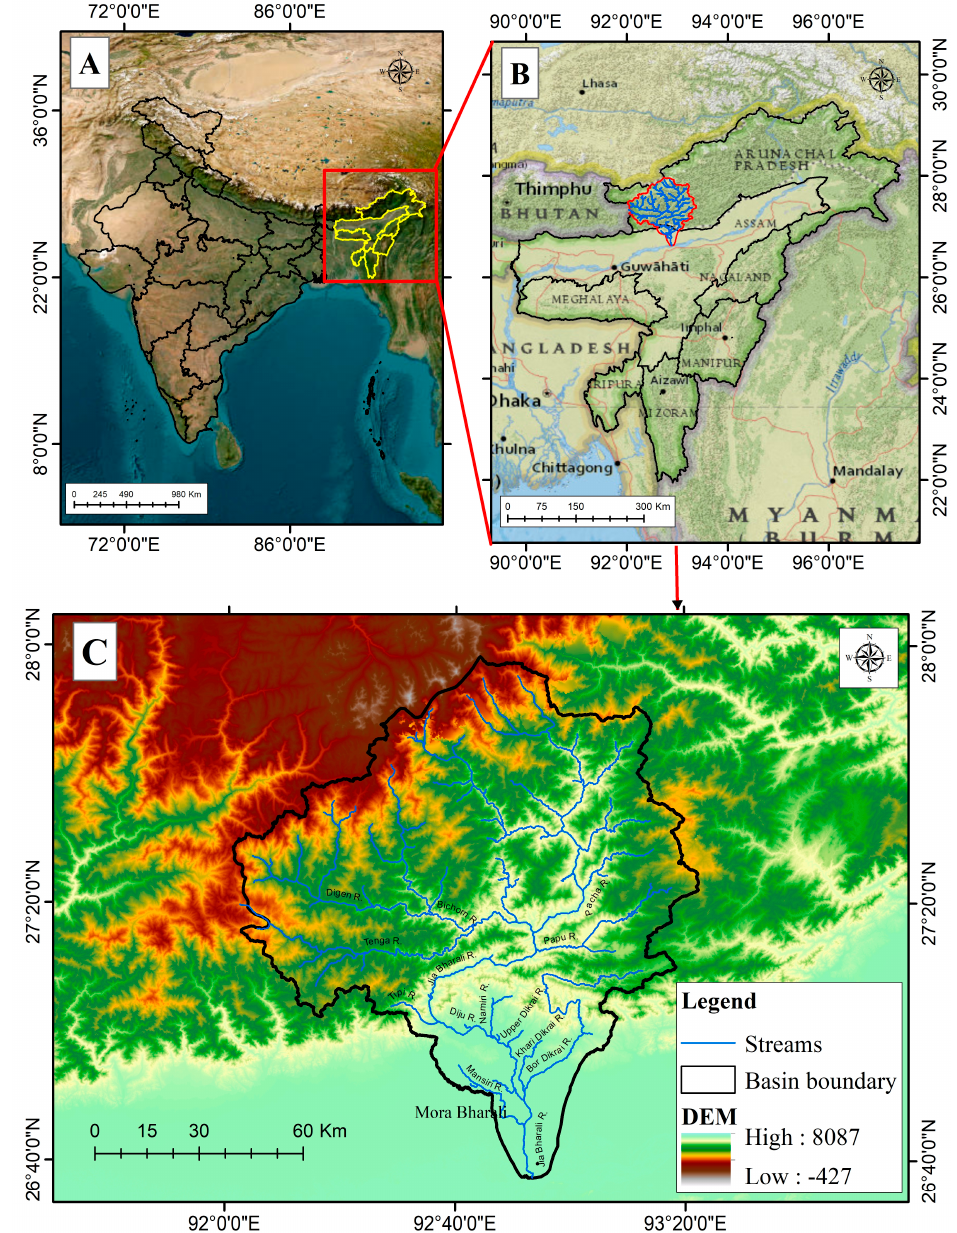
Figure 1. Location map of the study area. ( A ) India map showing northeast India; ( B ) northeast India showing the Jia Bharali River basin; ( C ) Jia Bharali River basin showing the main stream and its tributaries.